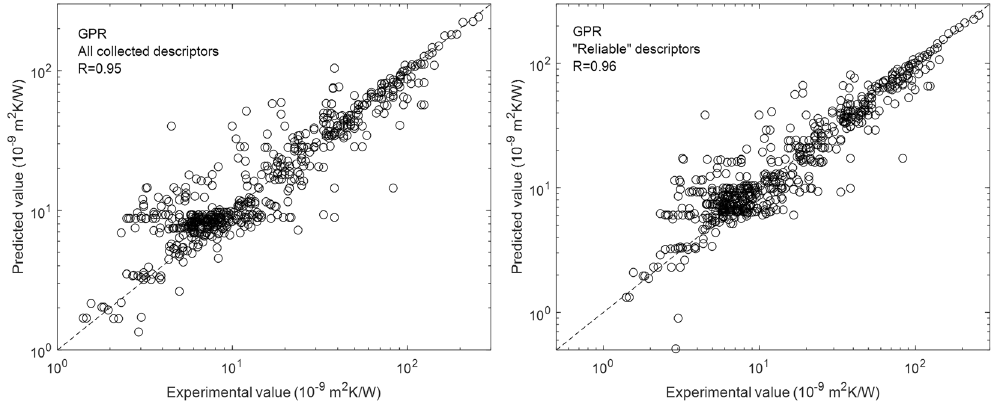
Figure 3. Correlation between the experimental values and the values predicted by the GPR model using the “reliable” descriptors and all collected descriptors.